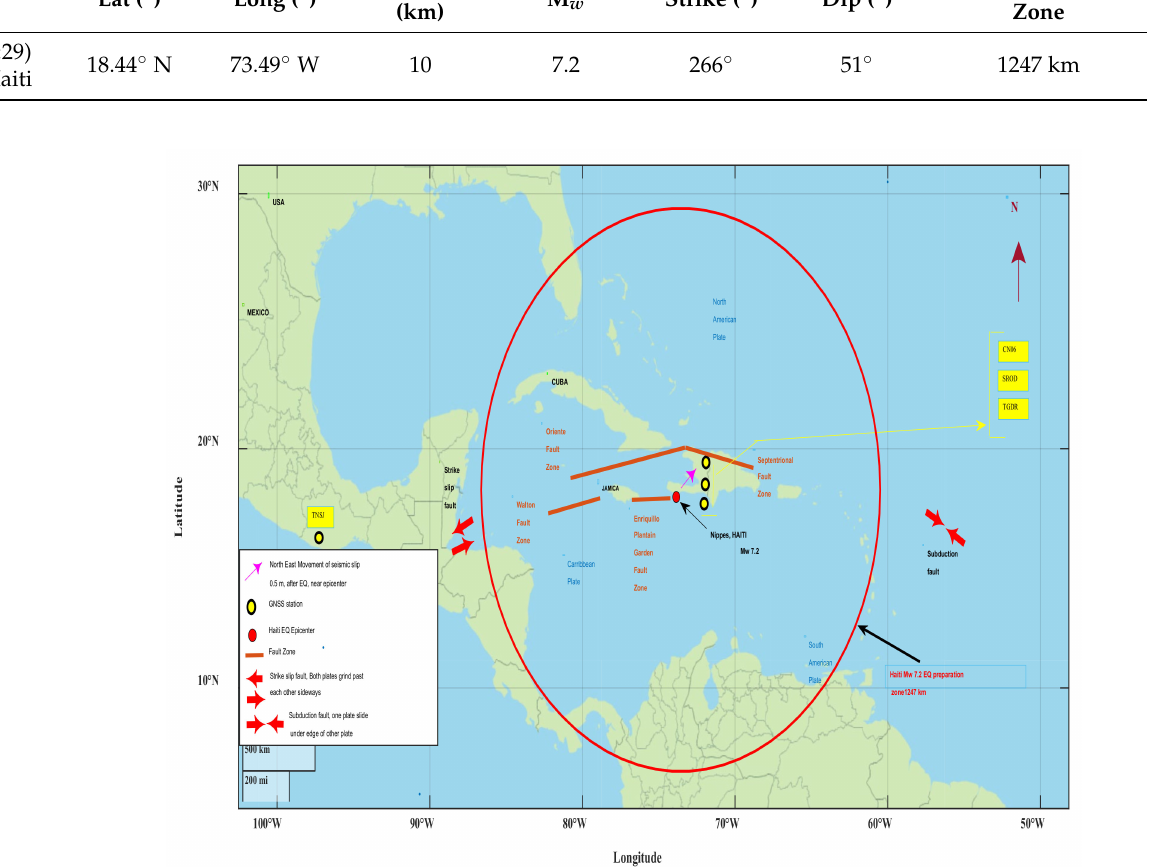
Figure 1. The geographical location of M w 7.2 EQ with the yellow dots represents the location of IGS stations. The red color circle represents the preparation zone estimated by the Dobrovolsky equation. The brown lines show the location of fault zones (information obtained from public domain data of